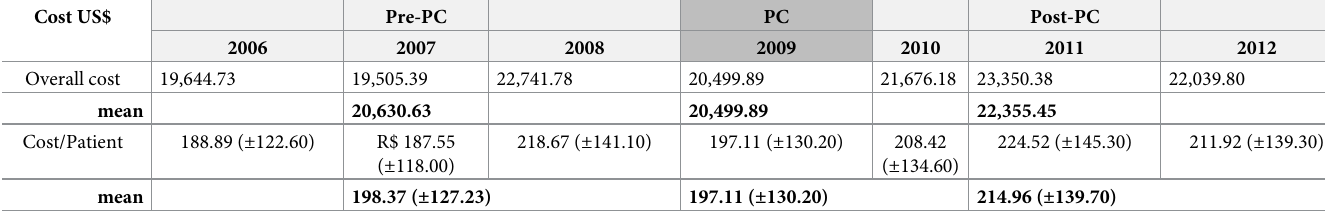
Table 2. Cost of the public health system with the assistance to hypertensive patients in the follow-up years of the study. Cost US$